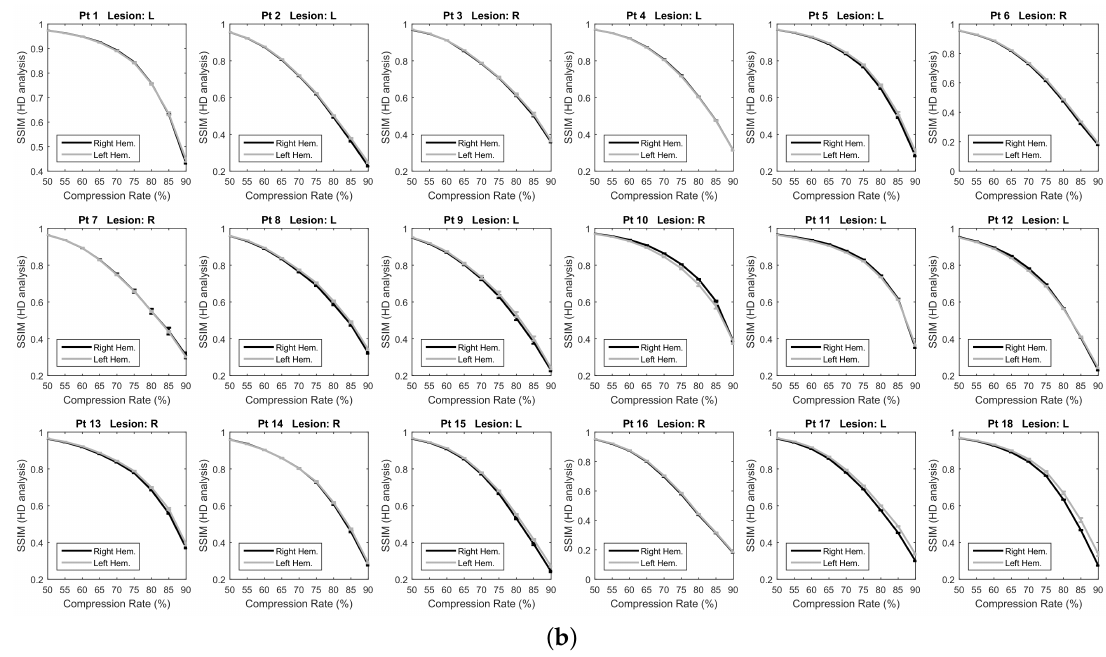
Figure 5. Comparison of the reconstruction quality of the EEG signals of the right (black line) and left (gray line) hemispheres. The average SSIM of the two hemispheres is depicted for increasing Compression Rates (CR). The analysis was carried out using: ( a ) High-Density EEG montage; and ( b ) Low-Density EEG montage.